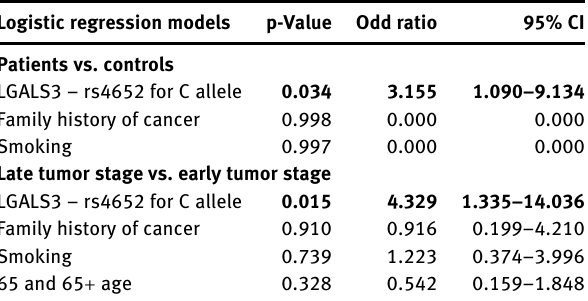
Table  : Logistic regression models for LGALS  rs  variant in LSCC group. Logistic regression